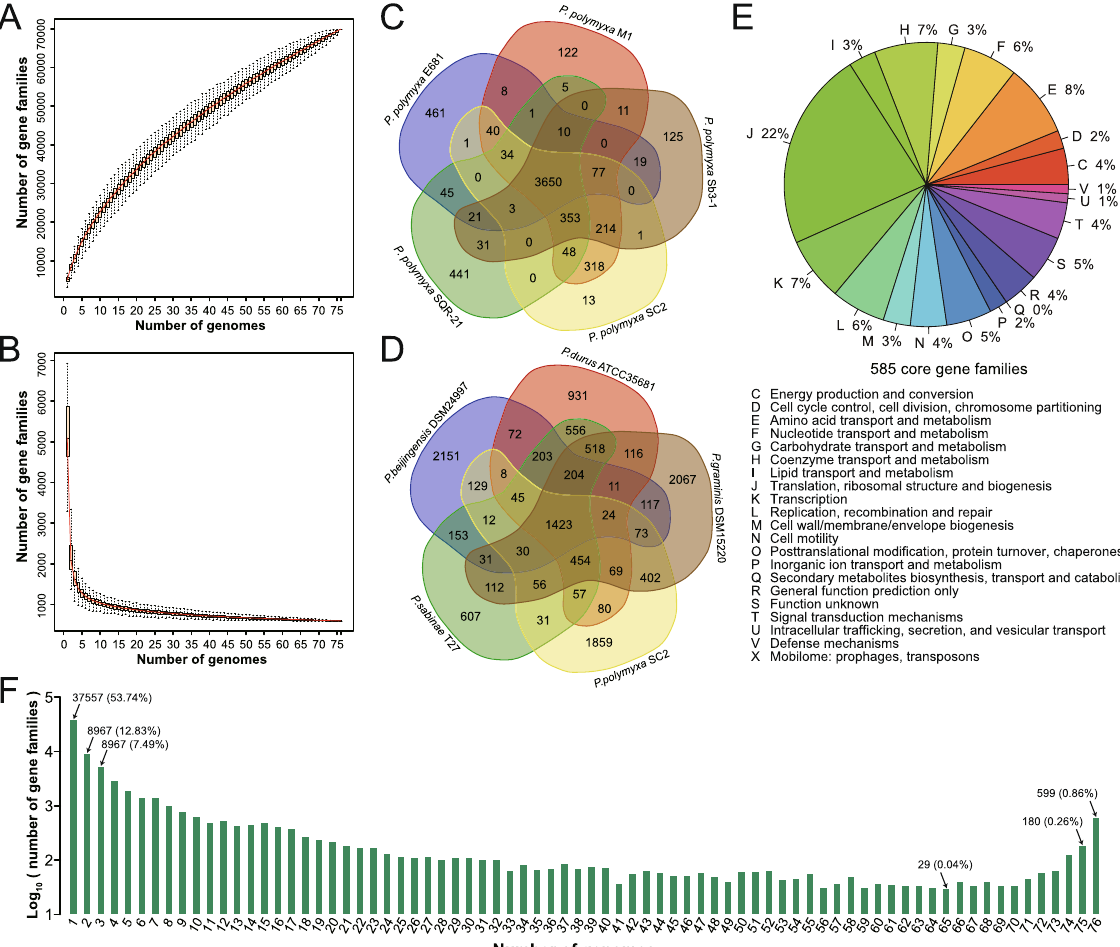
Figure 2. Pan-genome analysis of Paenibacillus . ( A ) The pan-genome accumulation curve. ( B ) The core- genome accumulation curve. ( C ) Venn diagram of the gene families in five Paenibacillus polymyxa strains. ( D ) Venn diagram of the gene families in five different species of Paenibacillus . ( E ) Functional distribution of the gene families in the core-genome. ( F ) Distribution of gene families shared in different numbers of